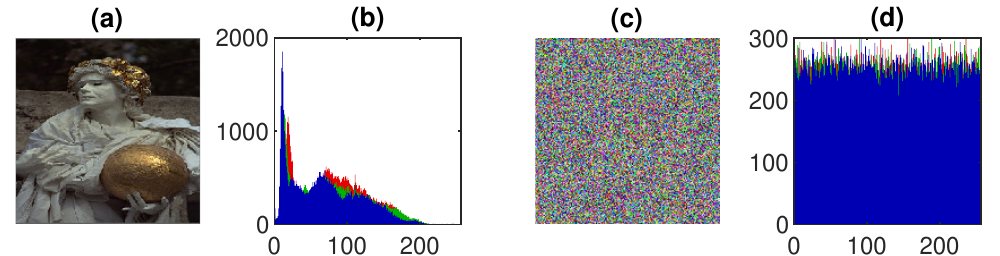
Figure 11. Histogram analysis of the image in Figure 2f: ( a ) the original image, ( b ) histogram of the original image, ( c ) encrypted image, ( d ) histogram of the encrypted